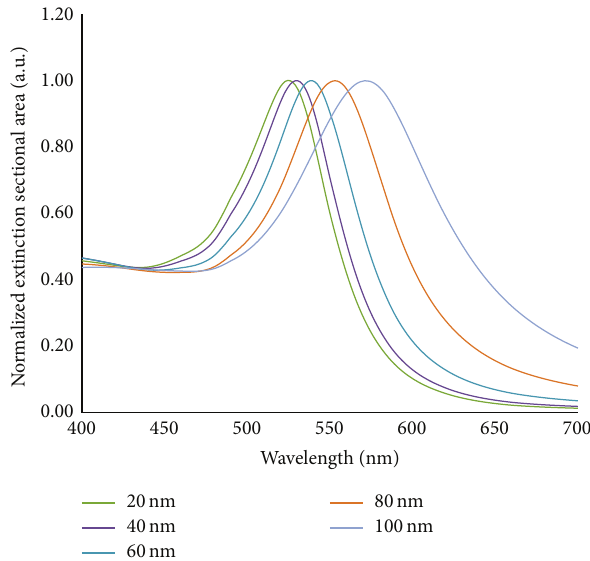
Figure 2: Normalized extinction cross-sectional area for spherical gold nanoparticles of diameters ranging from 20–100 nm. Data was obtained from a Mie theory simulation available online